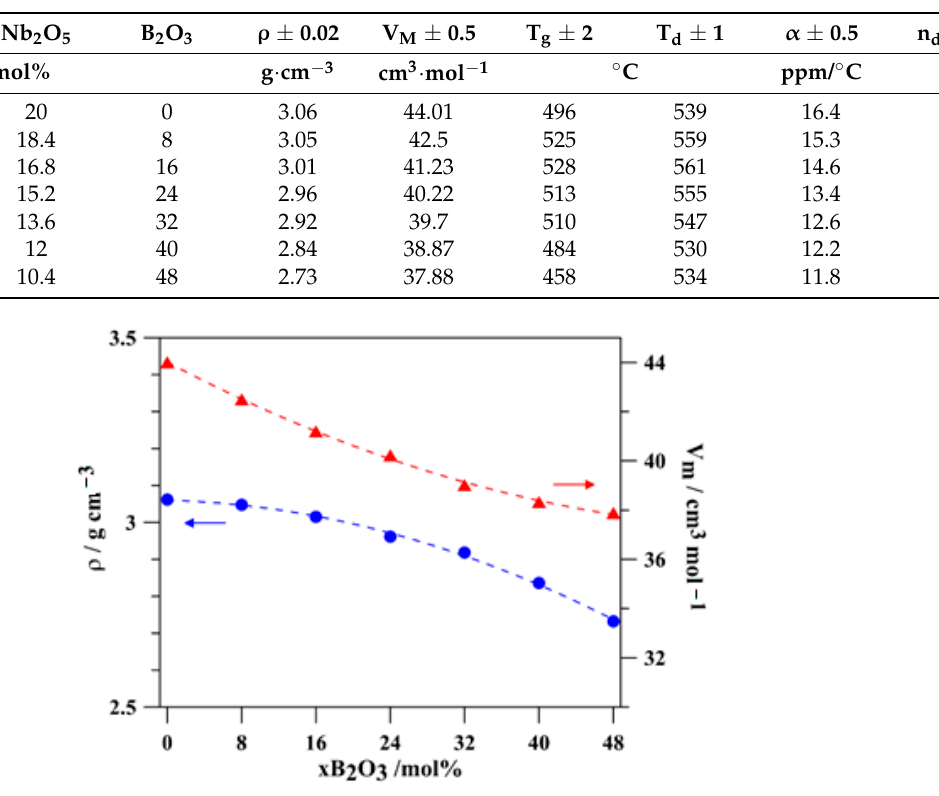
Figure 1. Density (blue line), ρ , and molar volume (red line), V M , in the glass series (100 − x)[40Na 2